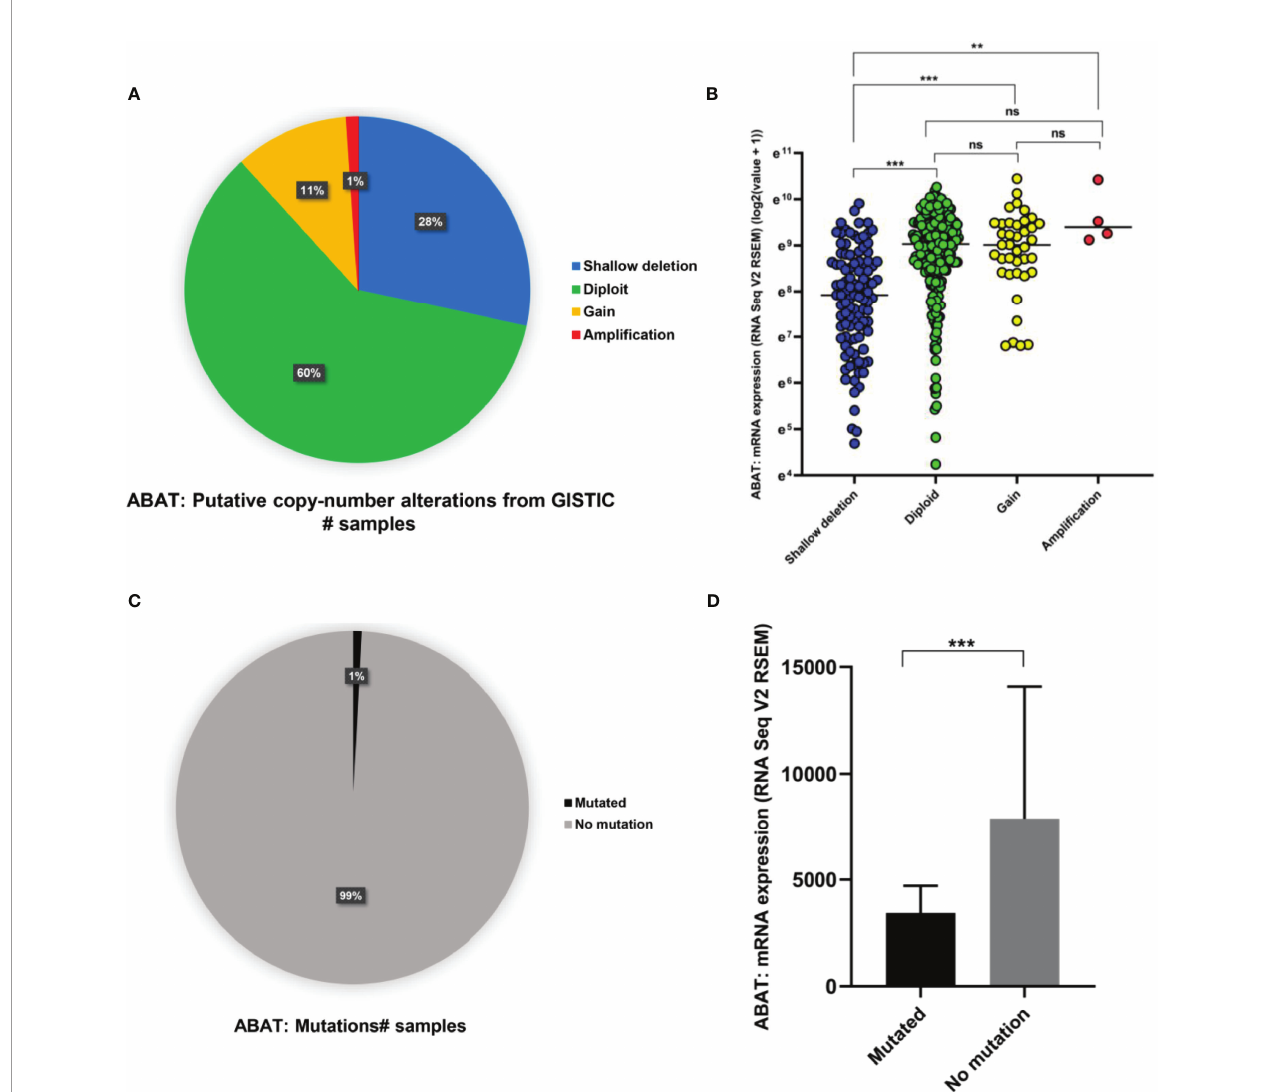
FIGURE 7 | Copy number variation and gene mutation of ABAT. (A) The proportion of various types of copy number variations of ABAT. (B) The effect of copy number variation on ABAT expression. (C) The proportion of gene mutation and no mutation of ABAT. (D) The effect of gene mutation on ABAT expression. NS, P = 0.05 or higher; **P < 0.01; ***P <